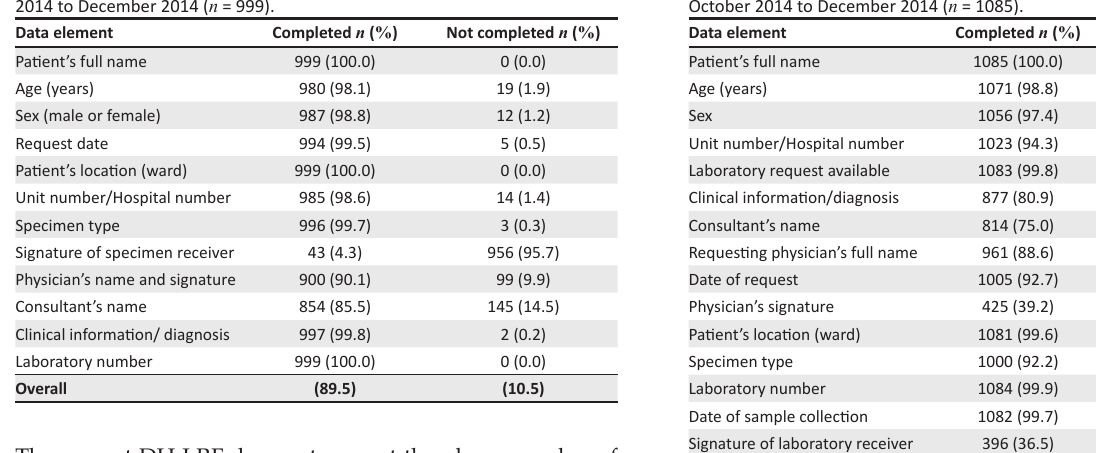
TABLE 2: Completeness of laboratory request forms submitted to Blood Transfusion Services of Aminu Kano Teaching Hospital, Kano, Nigeria, from